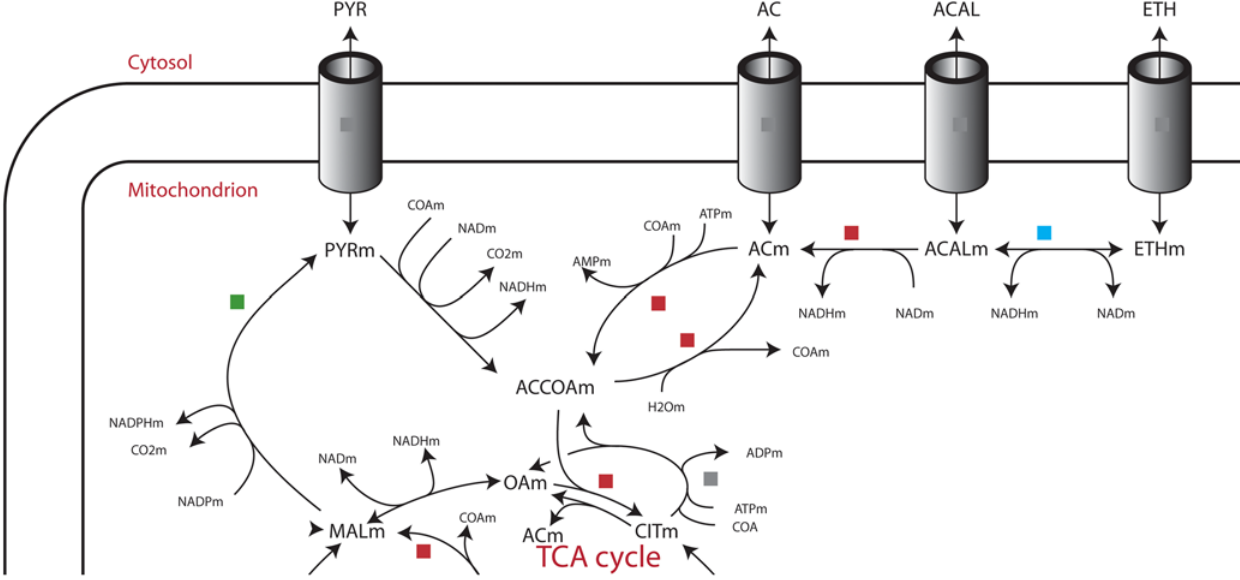
Figure 3. Response of central metabolism to phosphoketolase over-expression during growth on a glucose medium. A green box means that one or more isoenzymes of this reaction is down-regulated in the phosphoketolase over-expressingstrain relative to the wild type. A redbox indicates up-regulation. A blue box shows that some genes with this function are up-regulated while others are down-regulated. A grey box indicates that a gene could not be assigned to this function. The map was adapted from a map of A. niger metabolism published by Andersen et al [31].